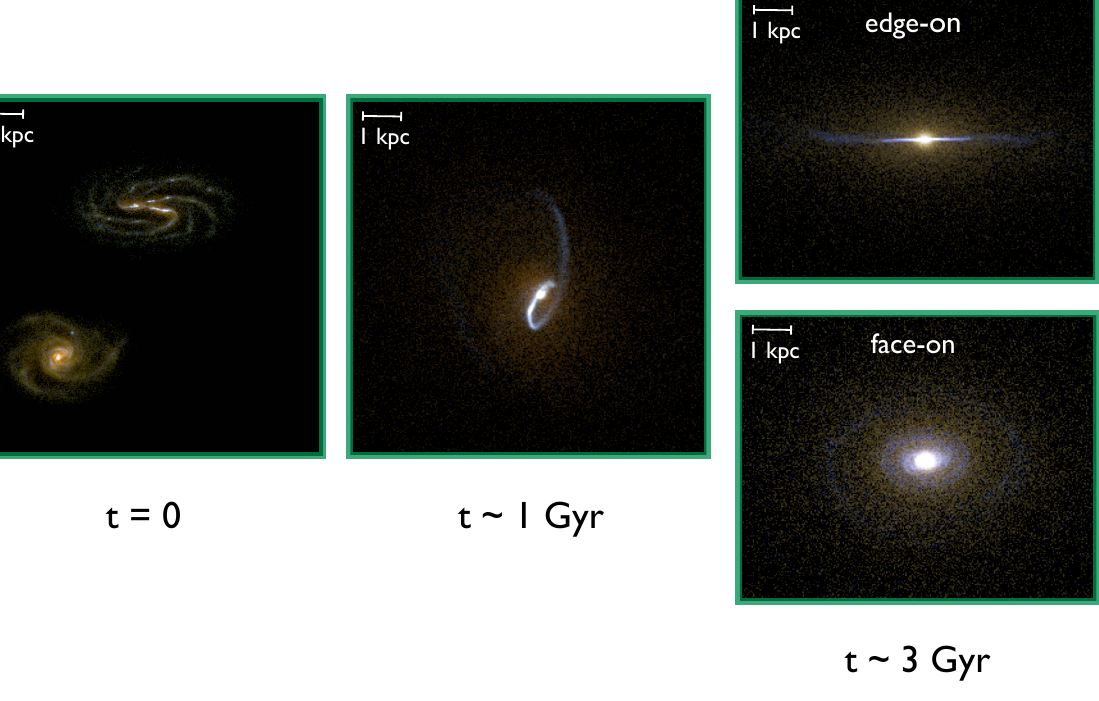
Figure 1. Three stages of the major merger between two giant spiral galaxies, Sa and Sd, simulated by GalMer (inclination = 75 ◦ , pericentre = 16 kpc, v encounter). Shown are RGB synthetic images combining simulated K -band ( red ); SDSS g -band ( green ); and GALEX near-UV ( blue